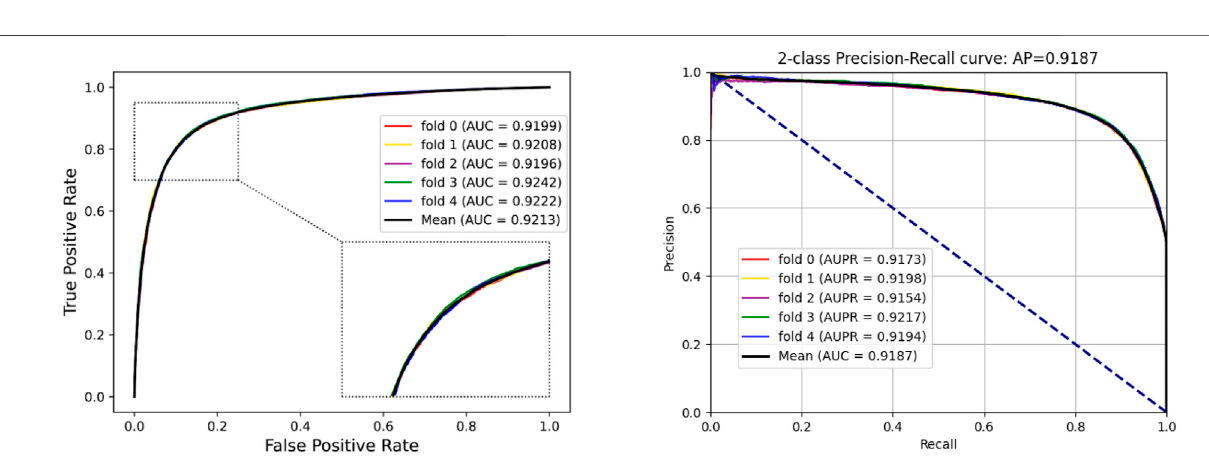
data provided by the PPIM dataset. The point to note is that the other six protein pairs of the unknown interaction are not proved by the literature, and there is no denying the possibility of interaction between them.